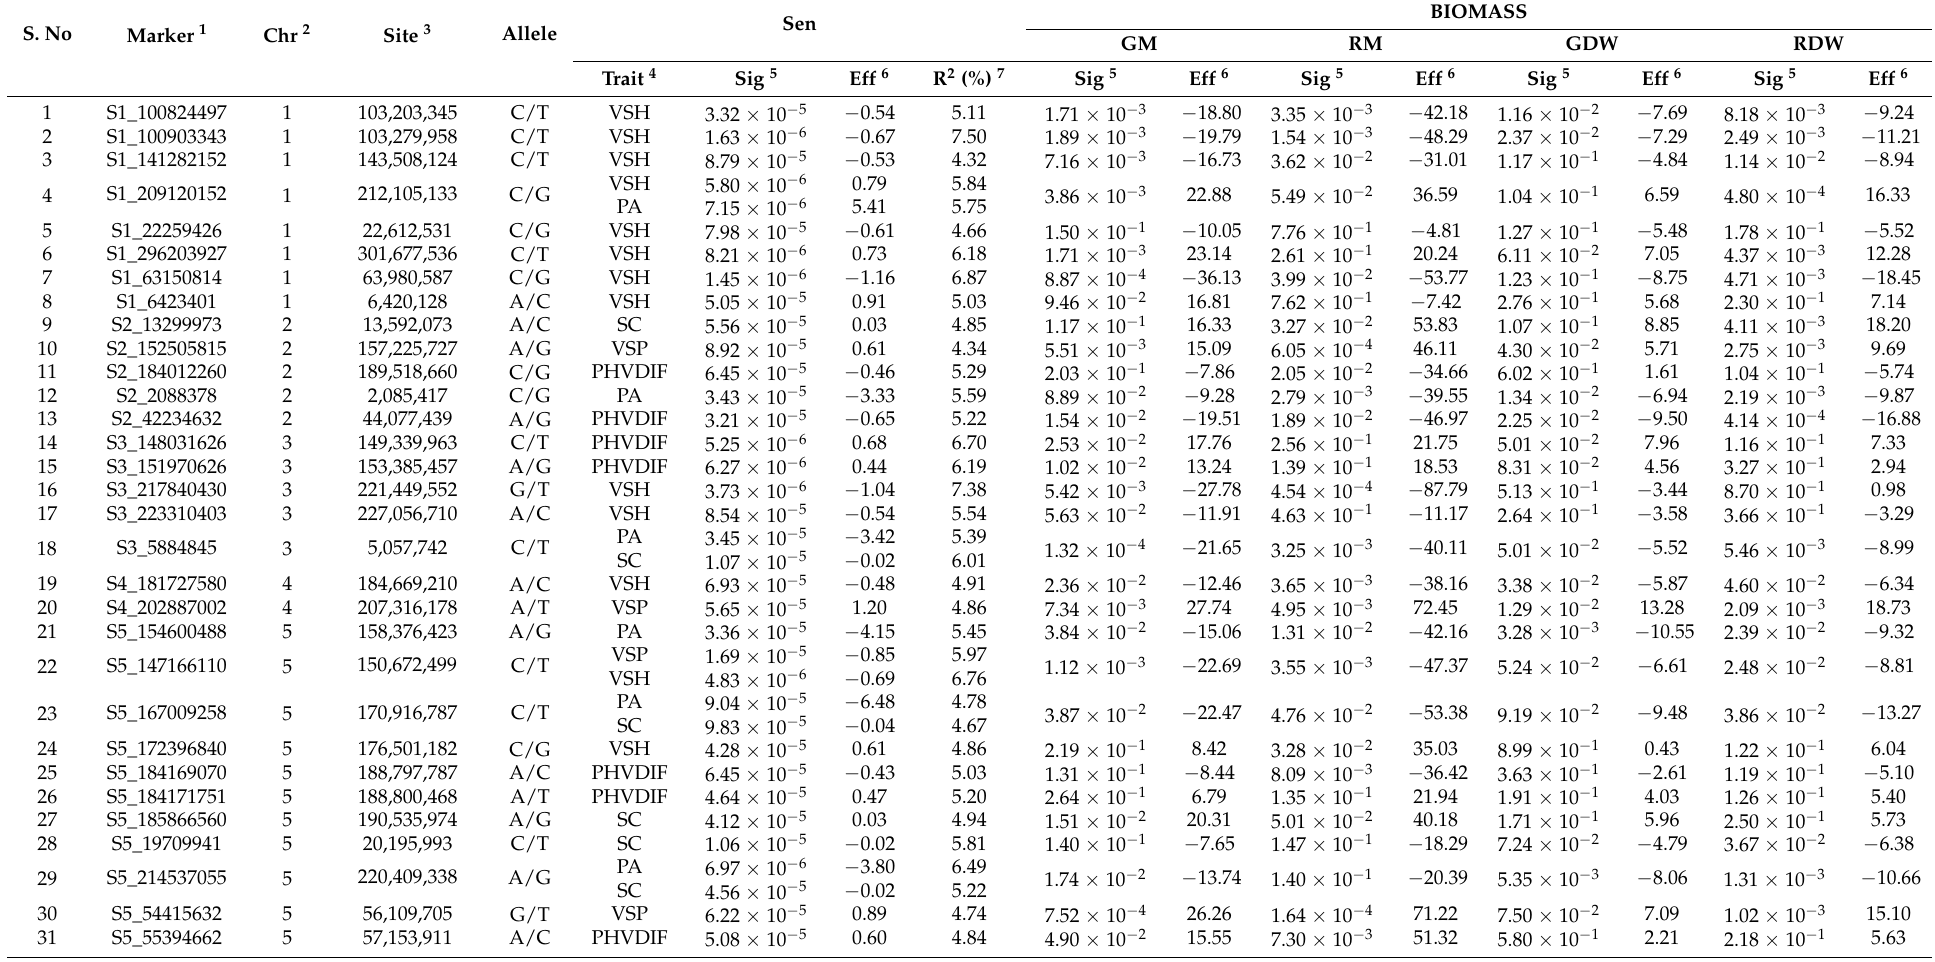
Table 2. List of SNPs related to senescence traits in comparison with biomass